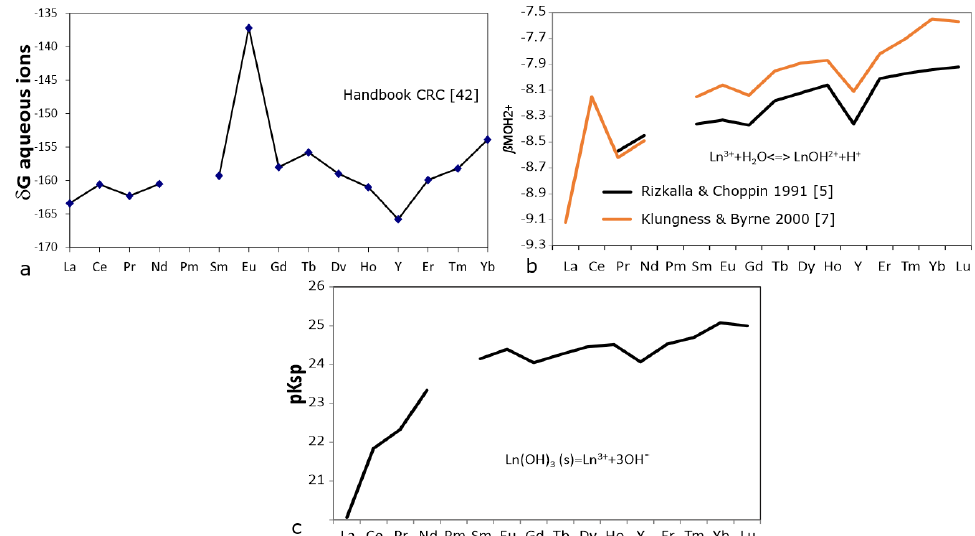
Figure 2. Physico-chemical parameters of rare earth elements and Y.( a ) Free energy of formation of aqueous ions [42]; ( b ) formation constant of mono-hydroxo-complexes [5,7]; ( c ) solubility product of tri-hydroxides